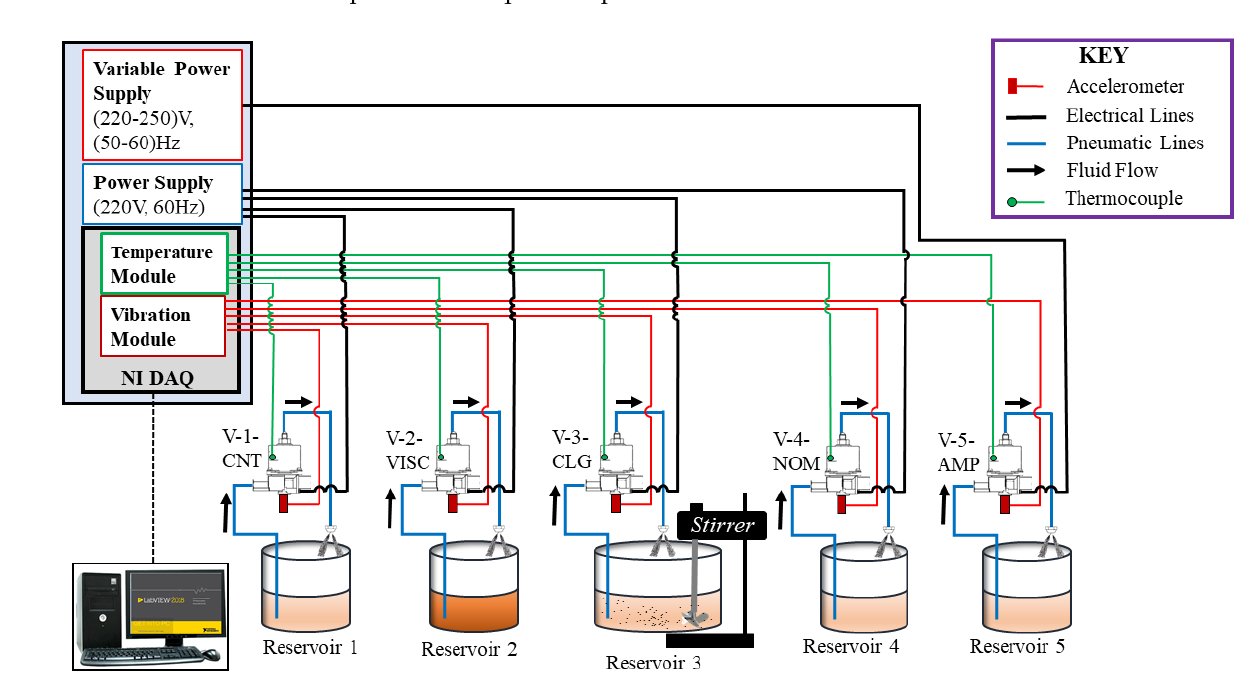
Figure 2. Experimental setup and data acquisition process.